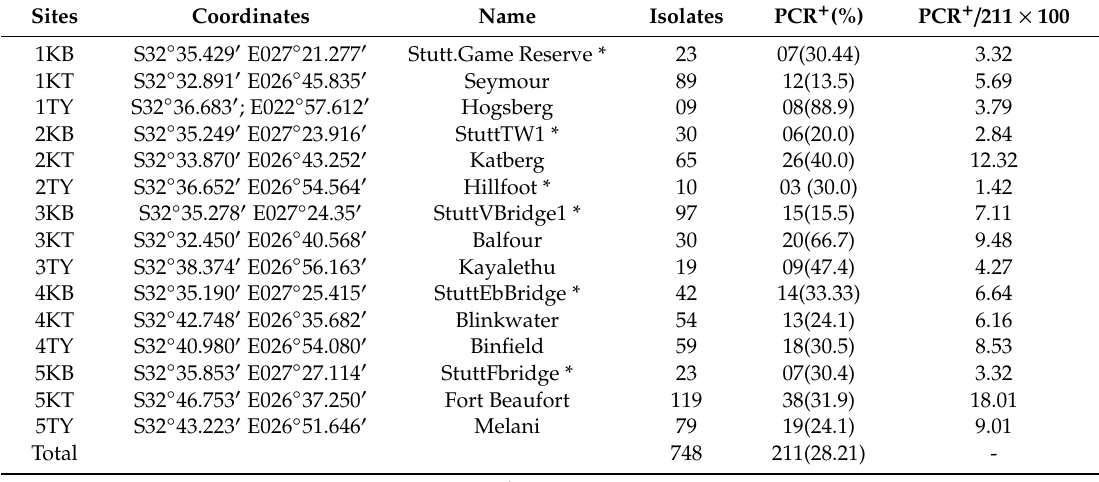
Table 2. Molecular confirmation of P. shigelloides among randomly selected isolates from IBGA plates. Sites